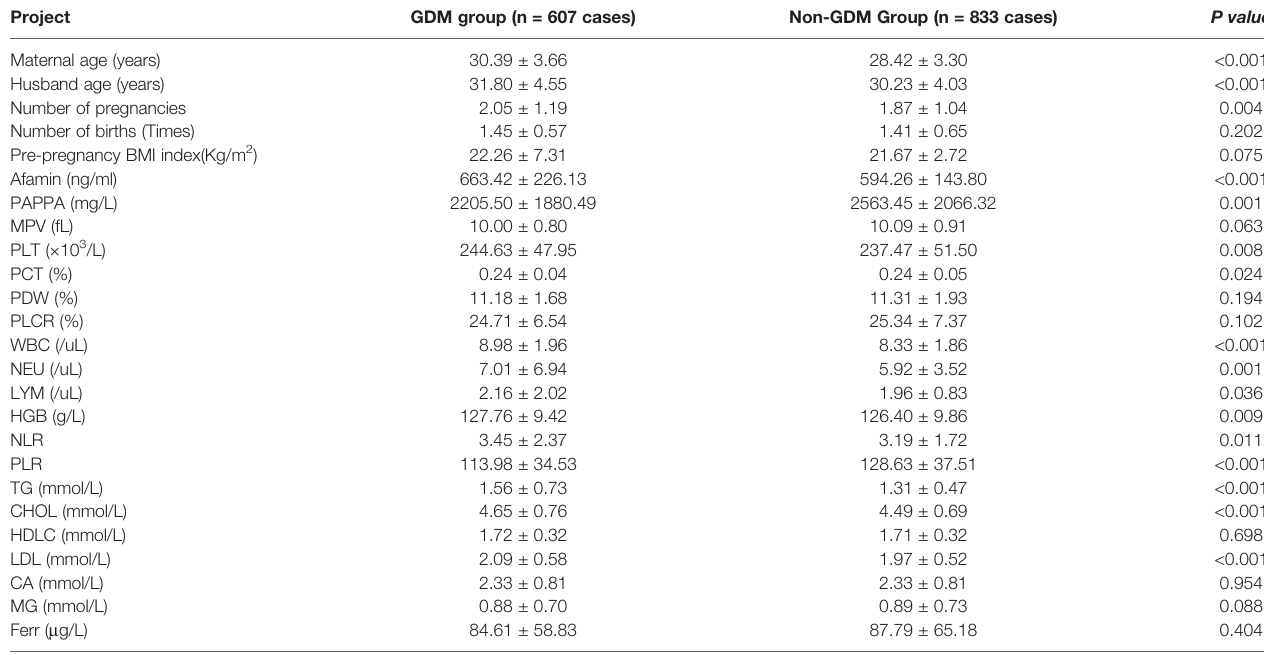
TABLE 1 | Comparison of clinical characteristics and laboratory indicators between the two groups of pregnant women.